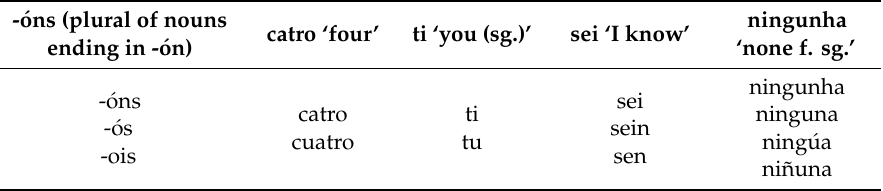
Table 1. Example of variables (features) and variants studied in this